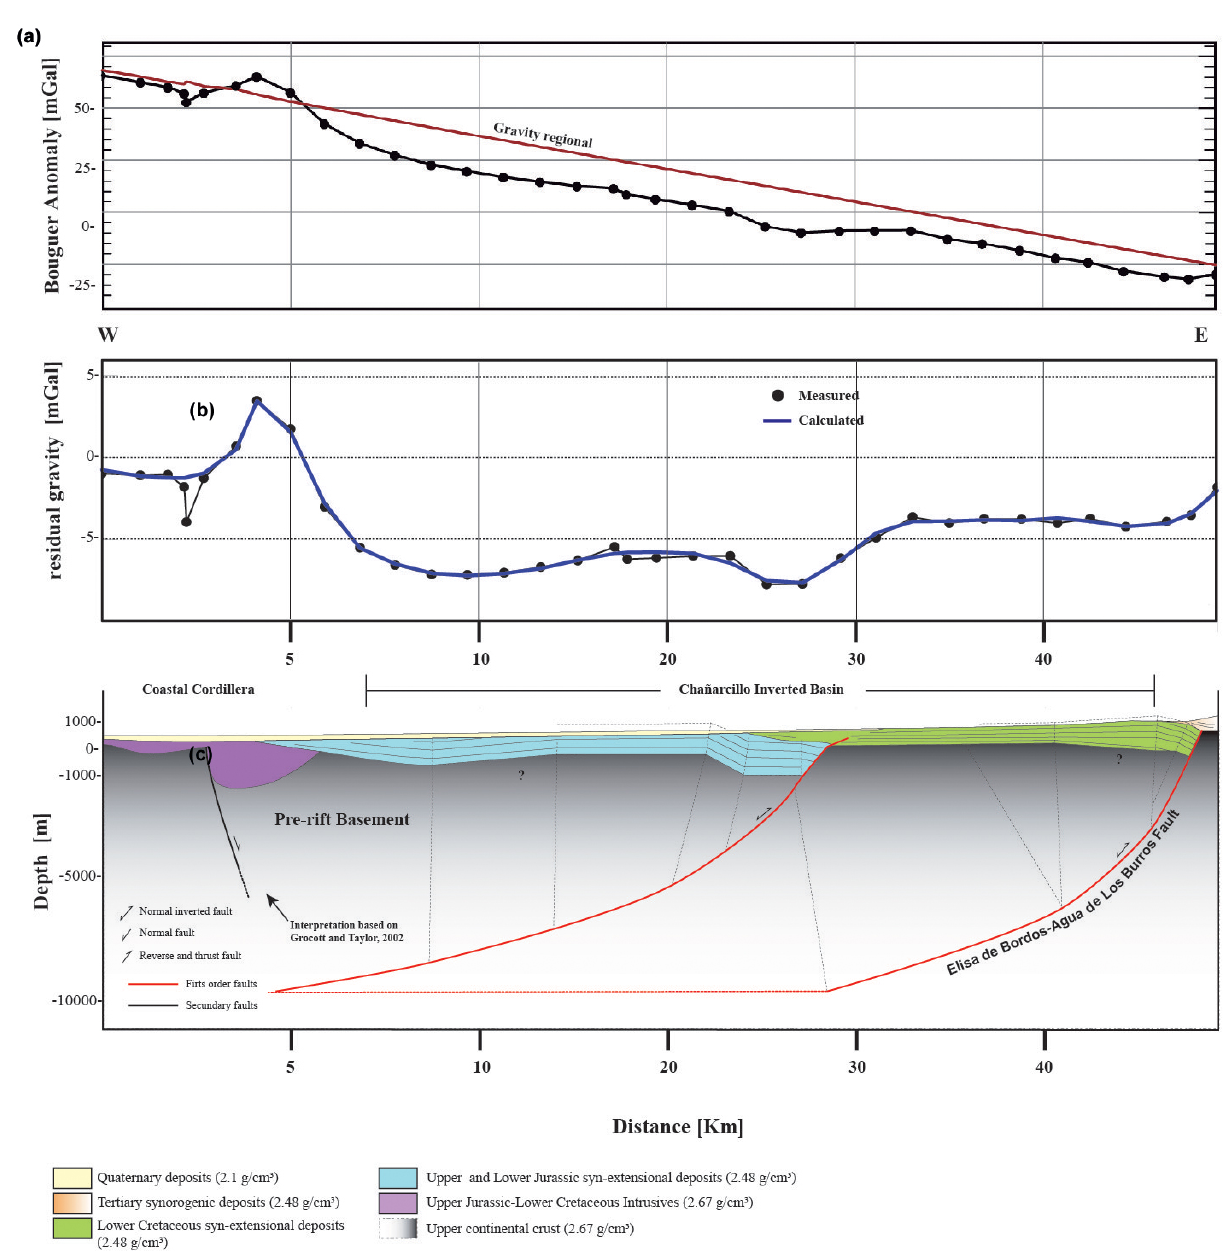
Figure 10. (a) Gravity profile B–B (cid:48) (see location in Figs. 2 and 8) showing the Bouguer and the regional anomaly; (b) gravity profile showing the measured gravity and the calculated gravity; (c) balanced cross section and structural interpretation constrained with field and gravity